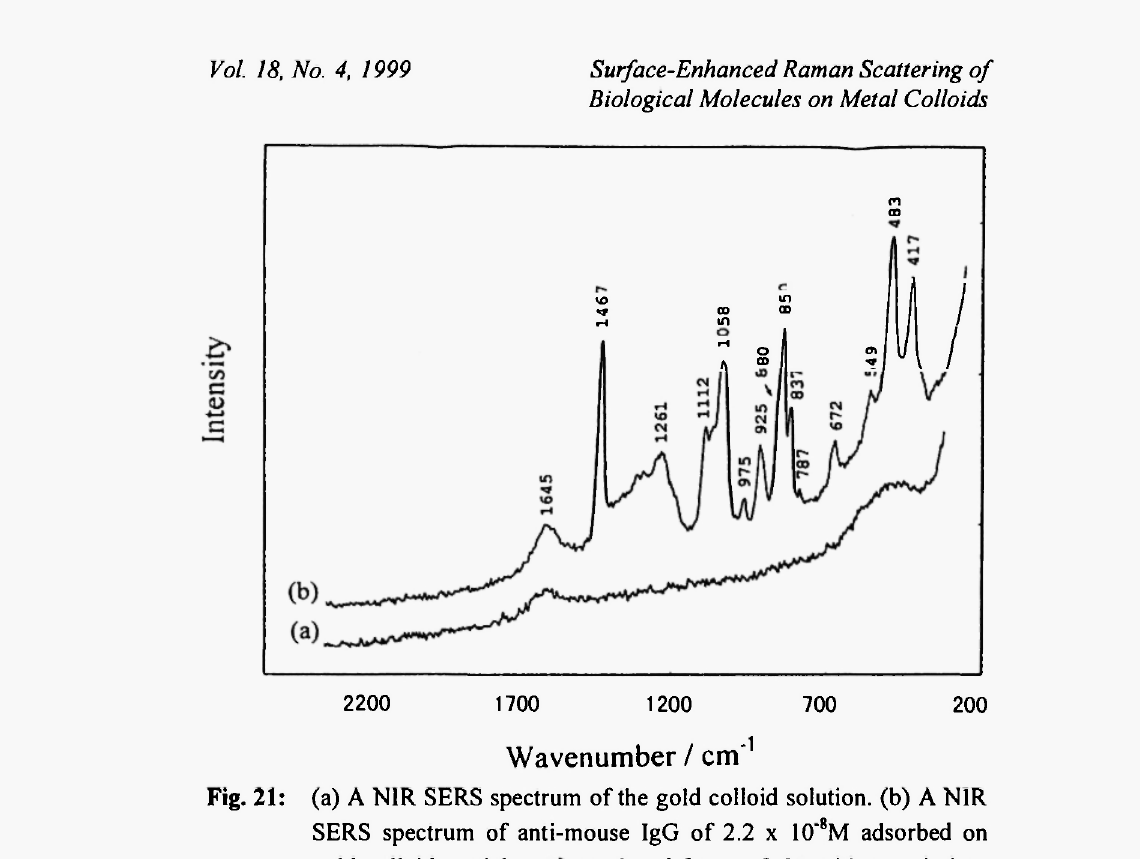
Fig. 21: (a) A N1R SERS spectrum of the gold colloid solution, (b) A N1R SERS spectrum of anti-mouse IgG of 2.2 χ 10" 8 M adsorbed on gold colloid particles. (Reproduced from ref. 31 with